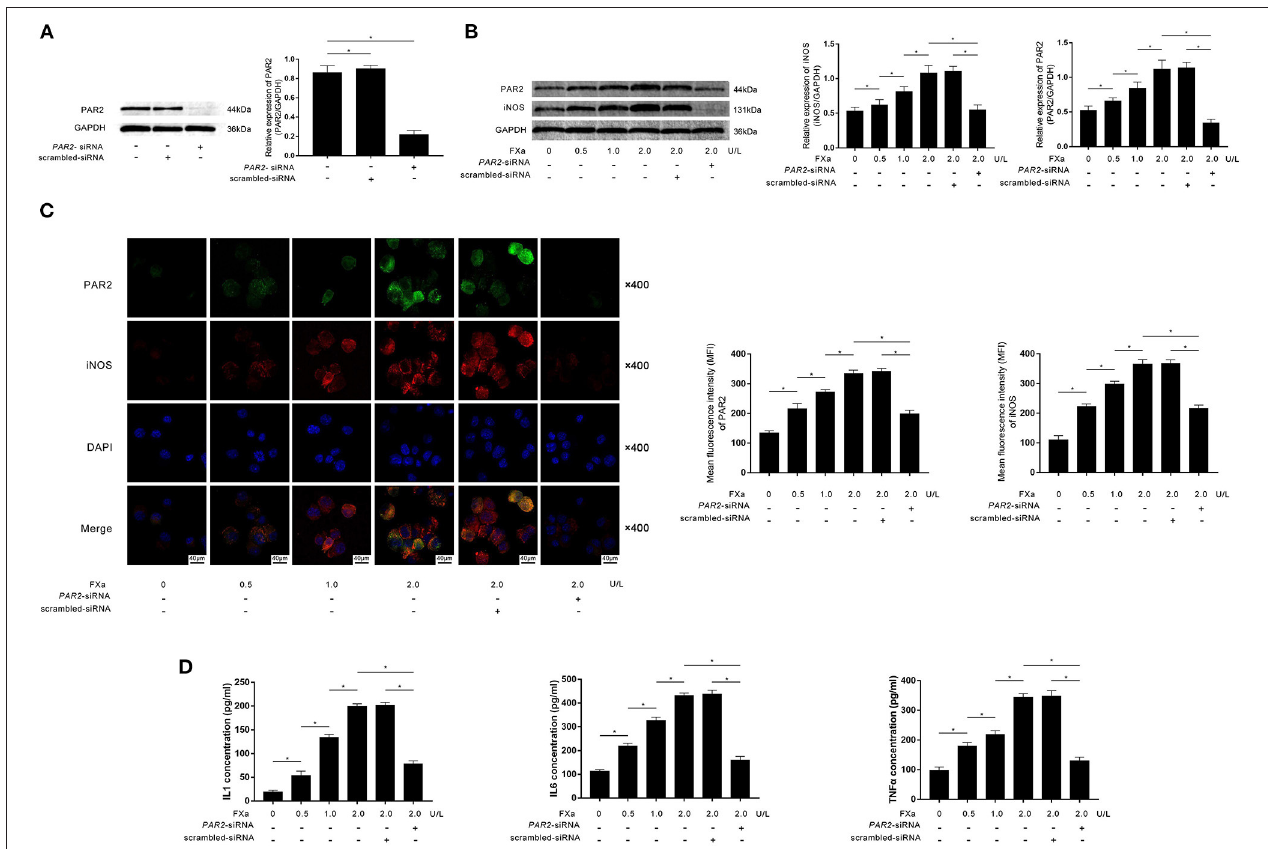
FIGURE 2 | (A) Immunoblots of PAR2 and GAPDH are demonstrated. Columns indicate relative expression levels of PAR2 in macrophages transfected with PAR2 -siRNA or scrambled siRNA. (B) Immunoblots of PAR2, iNOS, and GAPDH are demonstrated. Columns indicate the relative expression levels of iNOS and PAR2 in macrophages exposed to FXa at 0, 0.5, 1.0, and 2.0 U/L. Macrophages treated with FXa at 2.0 U/L were also transfected with PAR2 -siRNA and scrambled siRNA. (C) Immunofluorescence stains of PAR2, iNOS, DAPI, and their merged images are demonstrated. Columns indicate the MFI of PAR2 and iNOS in macrophages exposed to FXa at 0, 0.5, 1.0, and 2.0 U/L. Macrophages treated with FXa at 2.0 U/L were also transfected with PAR2 -siRNA and scrambled siRNA. (D) Columns indicate the concentrations of IL1, IL6, and TNF α in the cell culturing medium of macrophages exposed to FXa at 0, 0.5, 1.0, and 2.0 U/L. Macrophages treated